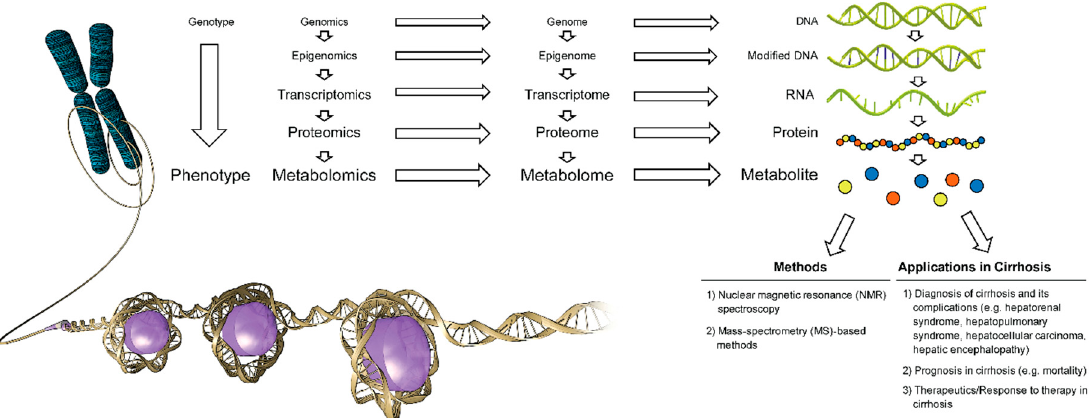
Figure 1. Current methods and applications of metabolomics in cirrhosis ( Used with permission of Baylor College of Medicine ).